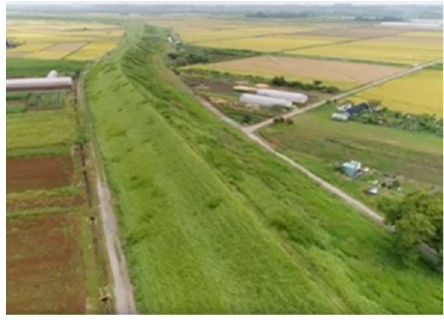
Figure 1. Riverdike in the high-water channel of the Tone River